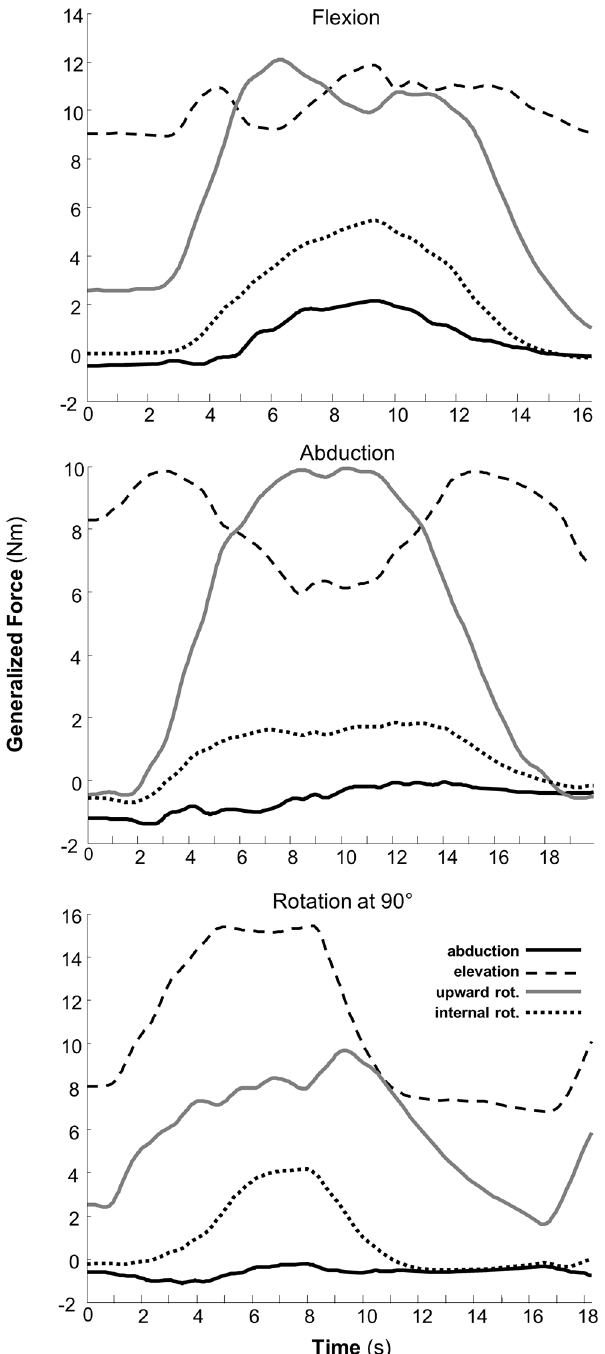
Fig 4. Scapulothoracic generalized coordinate forces (Nm) during shoulder flexion, abduction and rotation at 90° of shoulder abduction tasks. Scapula abduction (bold), elevation (dashed), upward rotation (gray), and internal rotation (dotted) generalized torques computed from an inverse dynamics analysis. A large sustained torque is required to keep the scapula elevated against gravity and requires additional upward rotation torque (gray) to rotate the scapula and lift the humerus during arm elevation